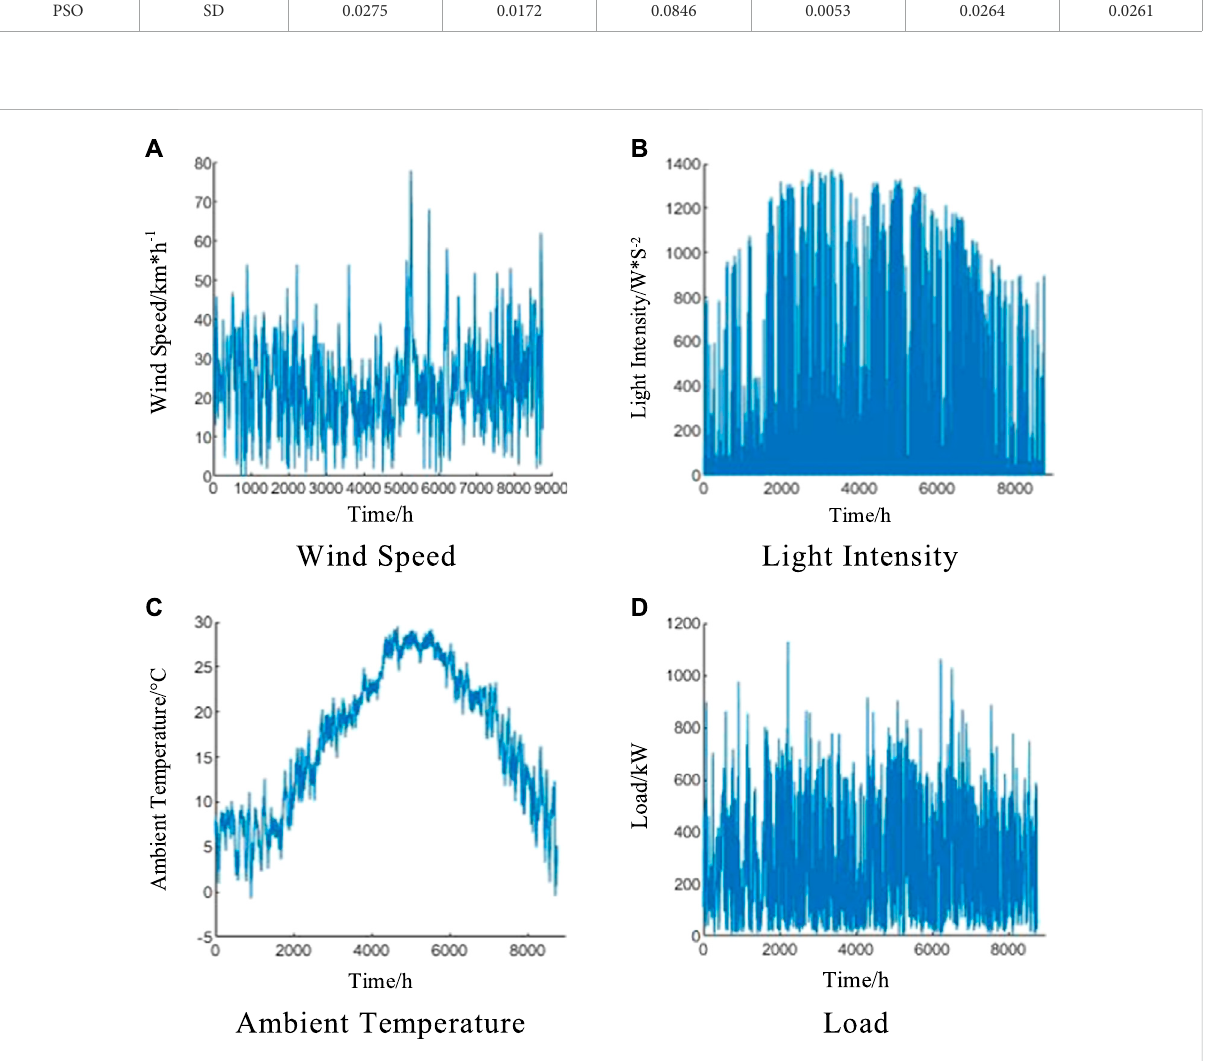
FIGURE 6 Weather and load data of a locality for 1 year. (A) Wind Speed; (B) Light Intensity; (C) Ambient Temperature; (D)